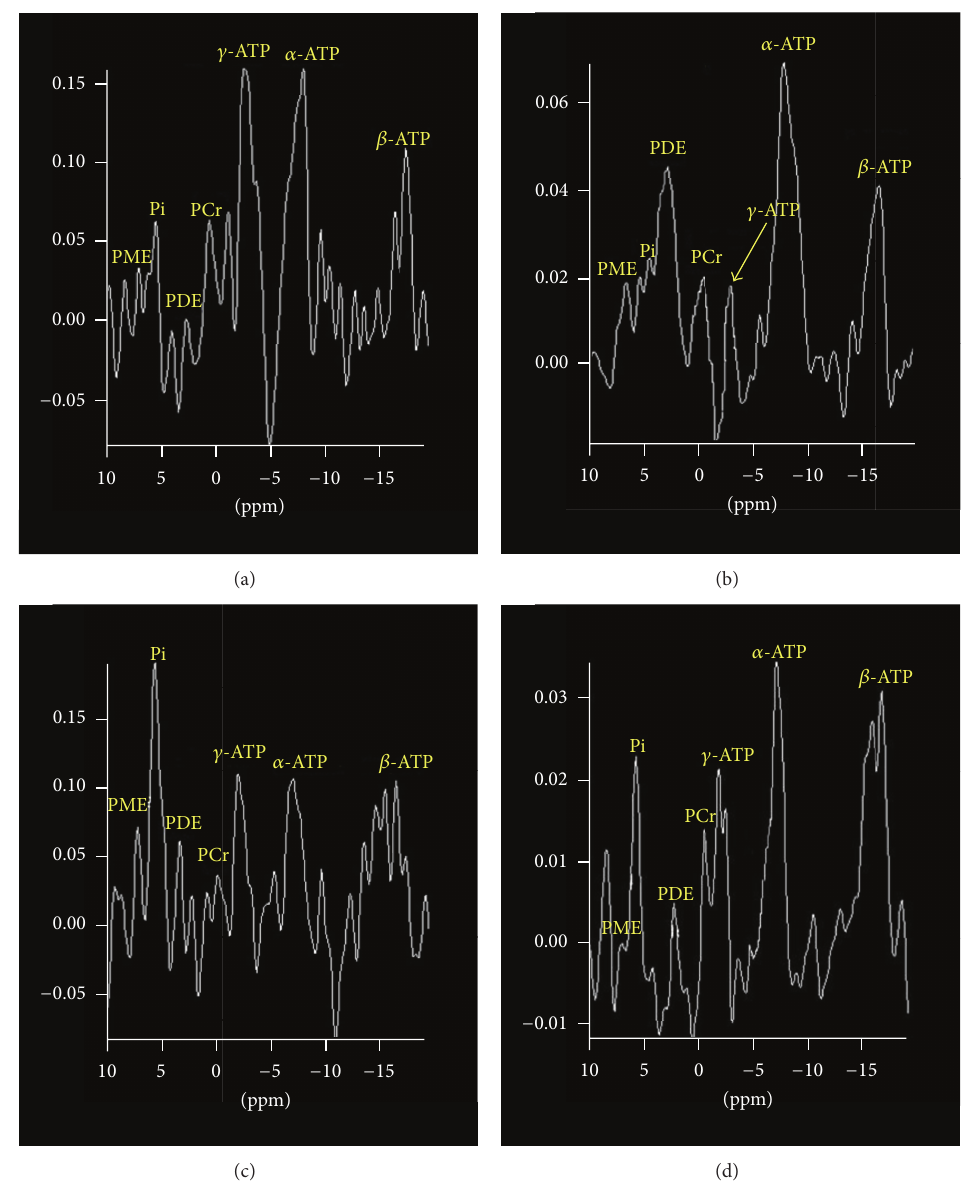
Figure 3: Peaks of phosphorus compounds were obtained from a solution containing HepG-2 cells. (a) MRS peaks were not ideal when adding 4mL ATP solution; (b) MRS peaks were ideal when adding 6 mL ATP solution; (c) MRS peaks were in disorder when adding 6mL ATP solution into the bottle containing A549 cells; and (d) MRS peaks were ideal when adding 8mL ATP